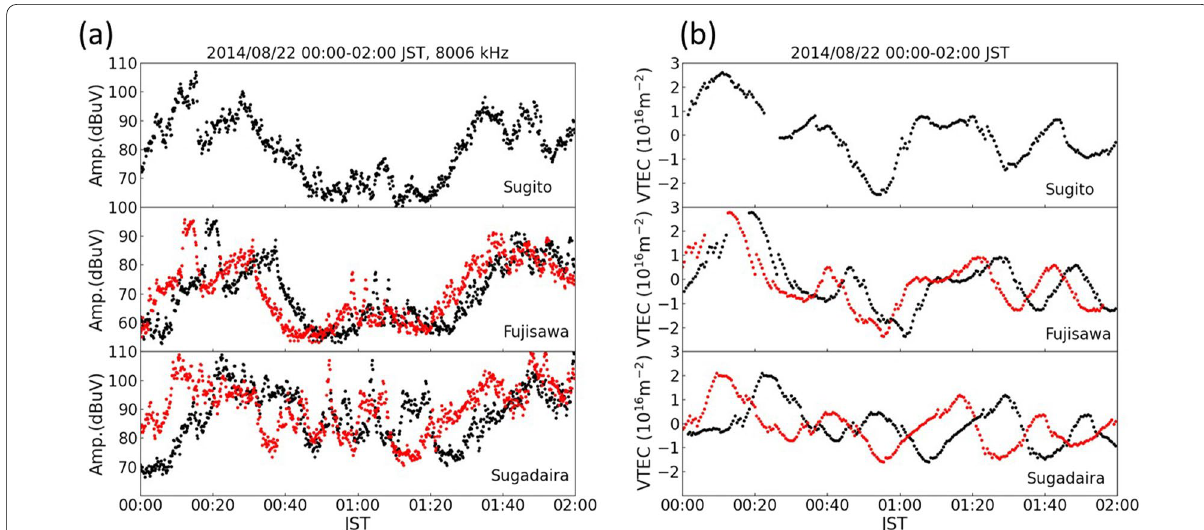
Fig. 3 Cross-correlation analysis (i.e., time lag analysis) of the HFD and GPS-TEC data. a The amplitude of reflected radio waves obtained from the three HFD receivers (Sugito, Fujisawa, and Sugadaira) on August 22, 2014, 00:00–02:00 JST. b Vertical GPS-TEC data above the HFD sensing area (i.e., mid-points between Tx and Rx stations at Sugito, Fujisawa, and Sugadaira) during the same interval. The black dots are the original data and the red dots are the time-shifted data with the highest correlation coefficient relative to the data at the mid-point of Sugito